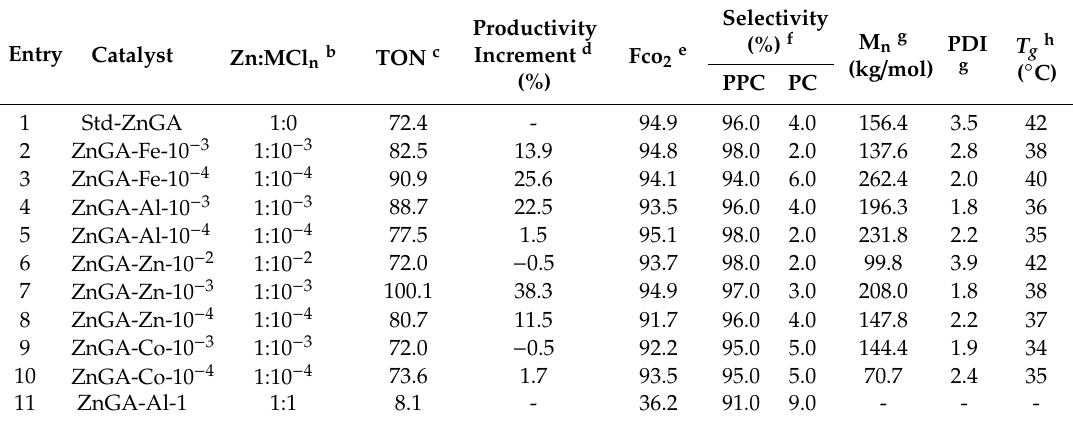
Table 1. Copolymerization of CO 2 with PO using ZnGA-M catalysts a .